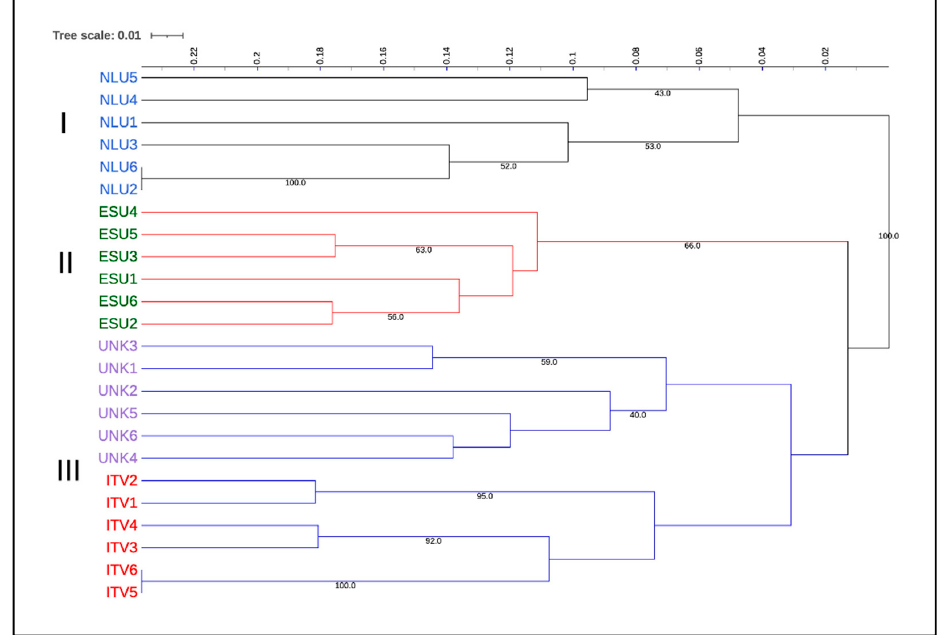
Figure 6. UPGMA dendrogram obtained from the SSR markers, based on Bruvo’s distances of the 24 A. araucana accessions individuated in the Pistoia nursery industry. Bootstrap values are also reported. Cophenetic correlation 0.82. Main clusters are indicated as I, II and III.